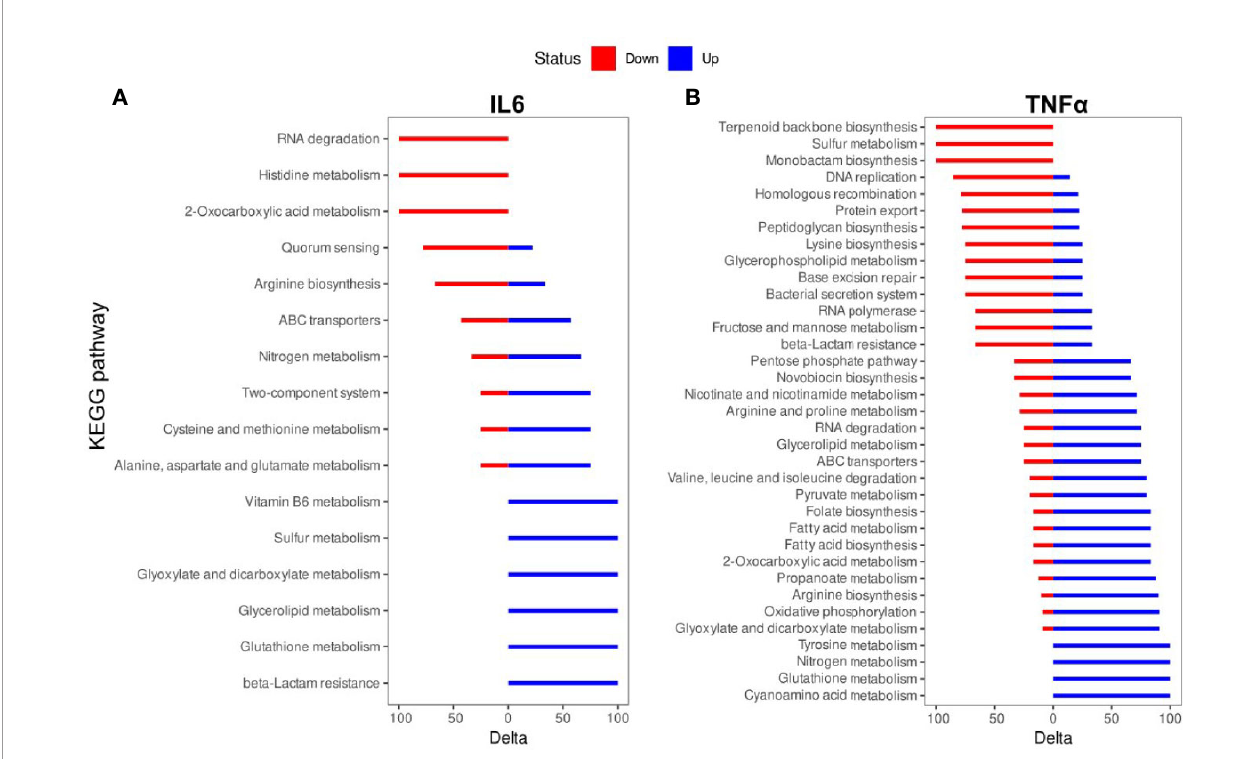
FIGURE 3 | Kyoto Encyclopedia of Genes and Genomes (KEGG) pathway enrichment analysis of differentially expressed genes (DEGs): (A) IL-6 vs. control; (B) . TNF a vs. control. The names of KEGG pathways are placed along the Y-axis. The X- axis represents the values of the Delta. Downregulated genes are shown in red color. Upregulated genes are show in blue color.